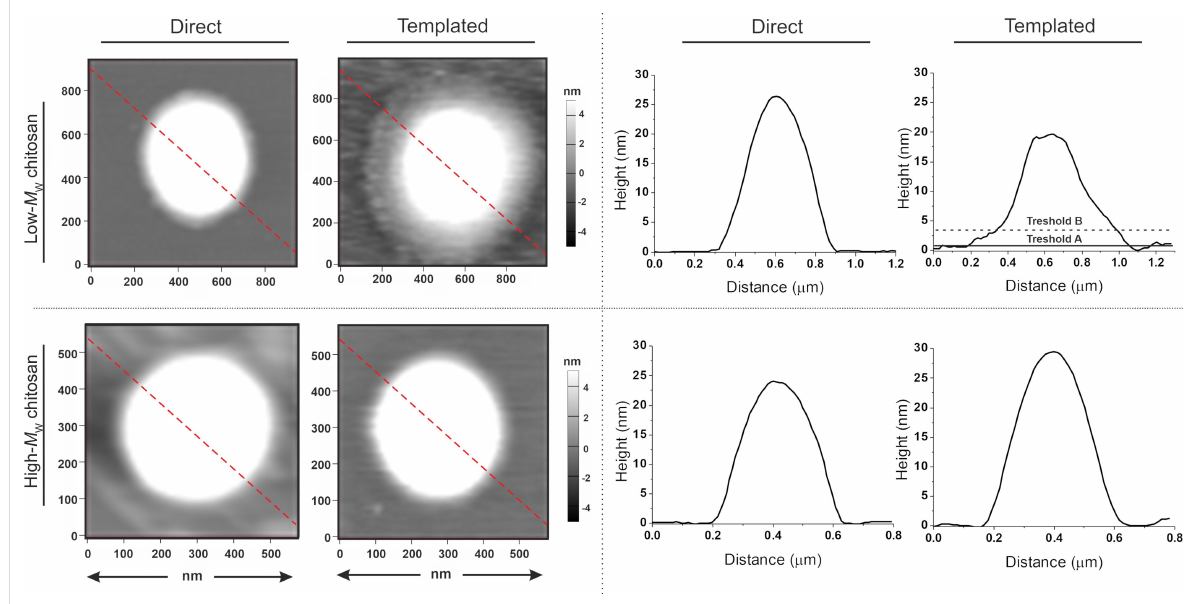
Figure 2: Tapping-mode AFM height images of chitosan/HA dried on mica (left) and height profiles corresponding to the red dashed lines in the images (right). For the templated Chit 35 /HA nanoparticles two thresholds were used to calculate separately the volume distributions of the nanoparti- cle corona and core. Please note that the HA corona is even more visible in amplitude images, see Supporting Information File 1, Figure S2.